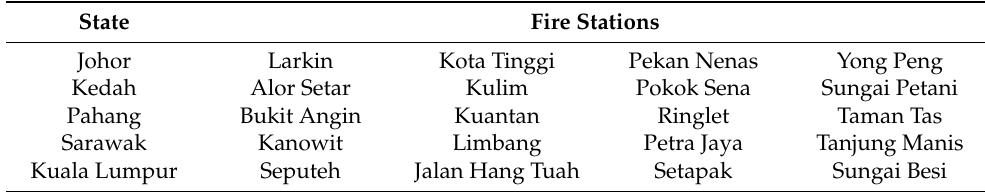
Table 1. Fire stations included in this